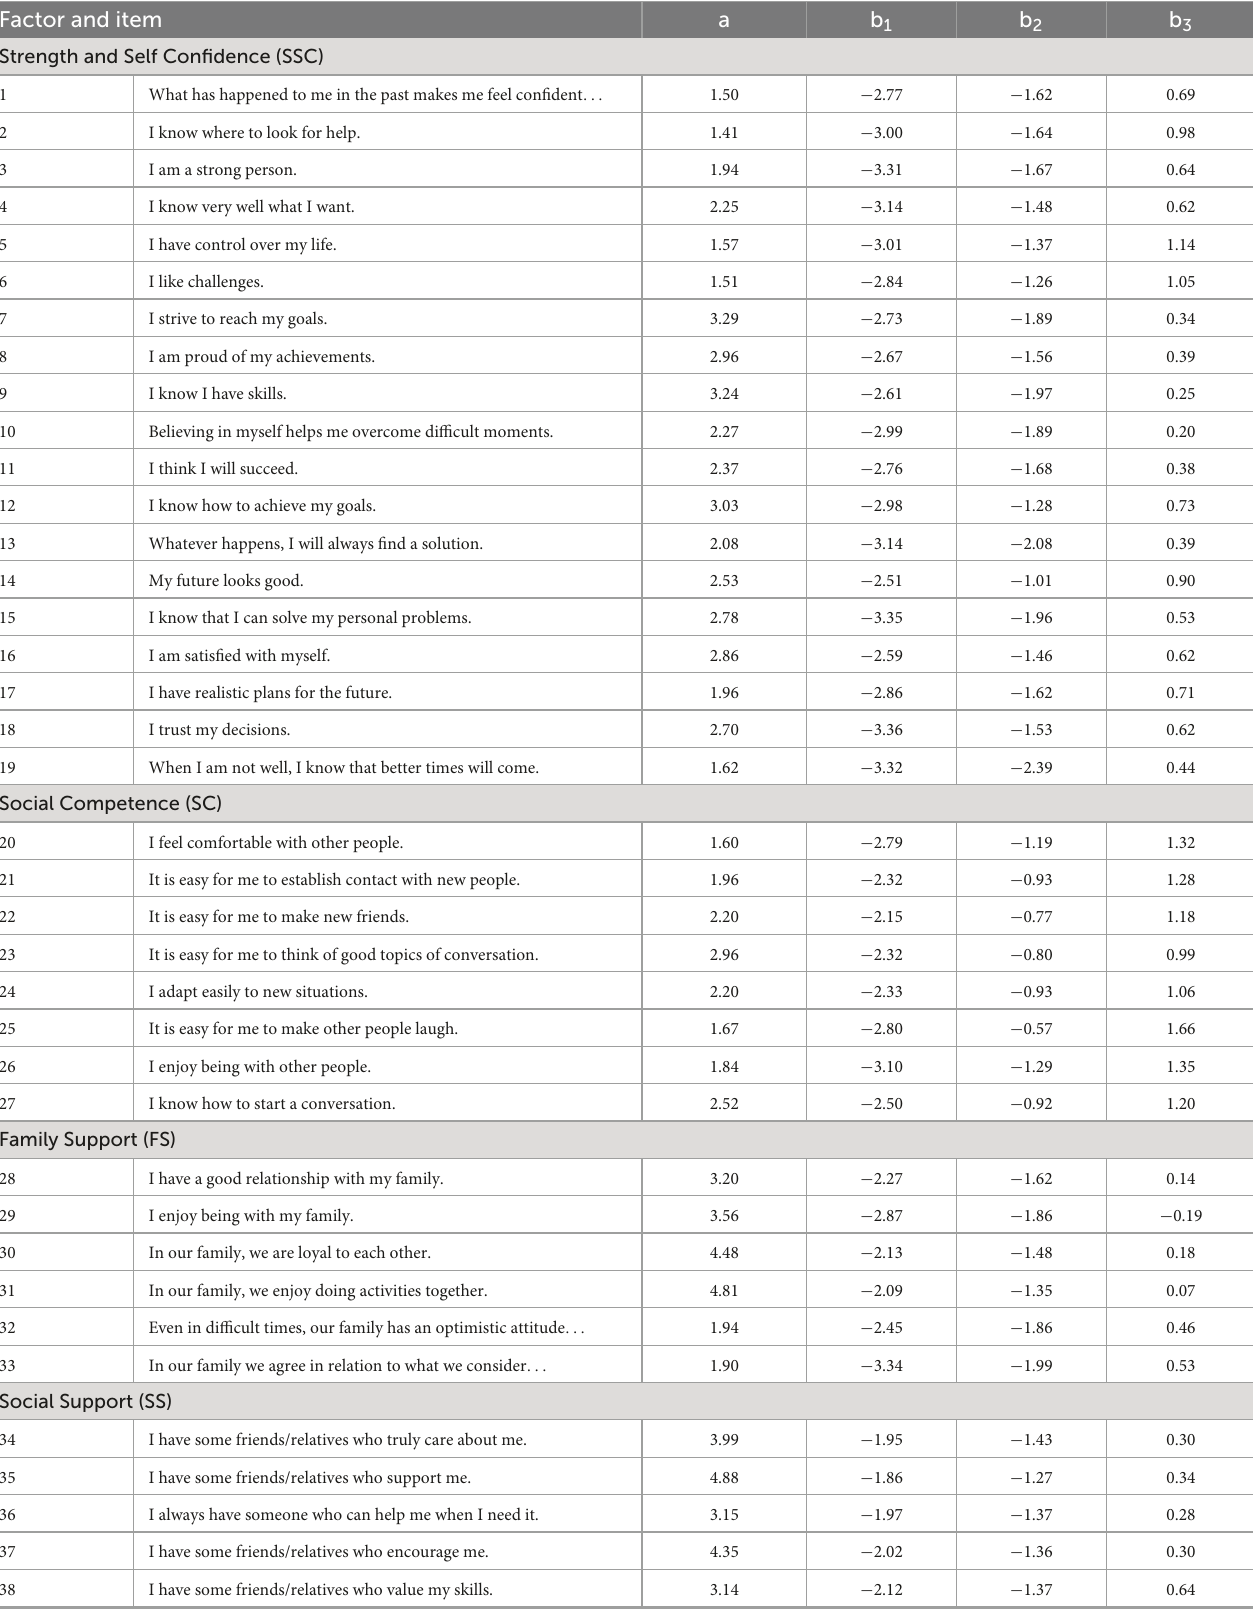
TABLE 3 Multidimensional parameters of discrimination and difficulty from the full information confirmatory graded response model (GRM). Factor and item a b 1 b 2 b 3 Strength and Self Confidence